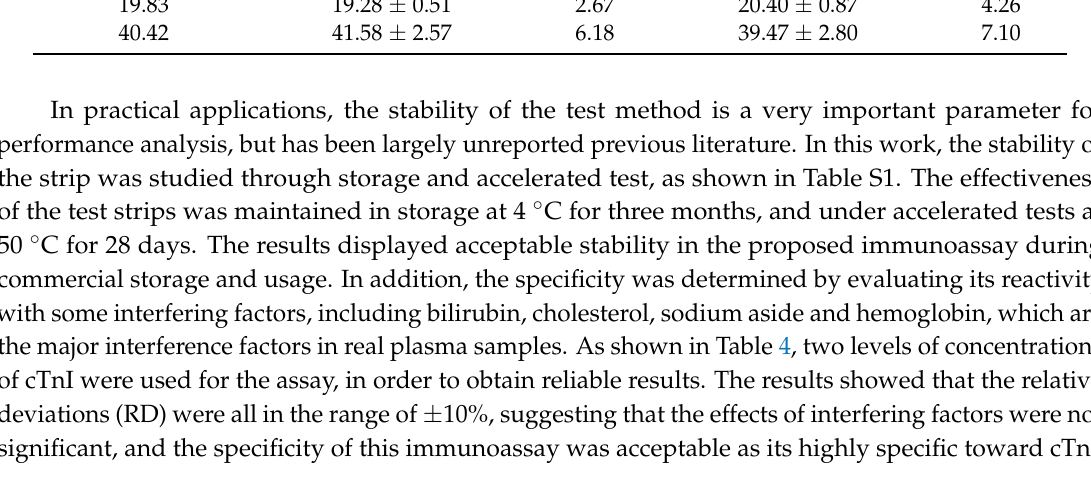
Table 4. The specificity study of the developed method with different